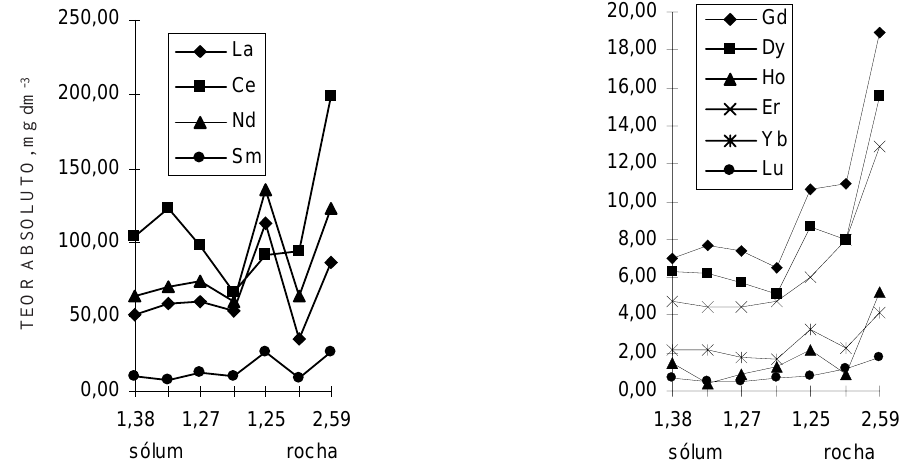
Figura 4. Diagramas de distribuição dos ETR em função da densidade para o perfil 1